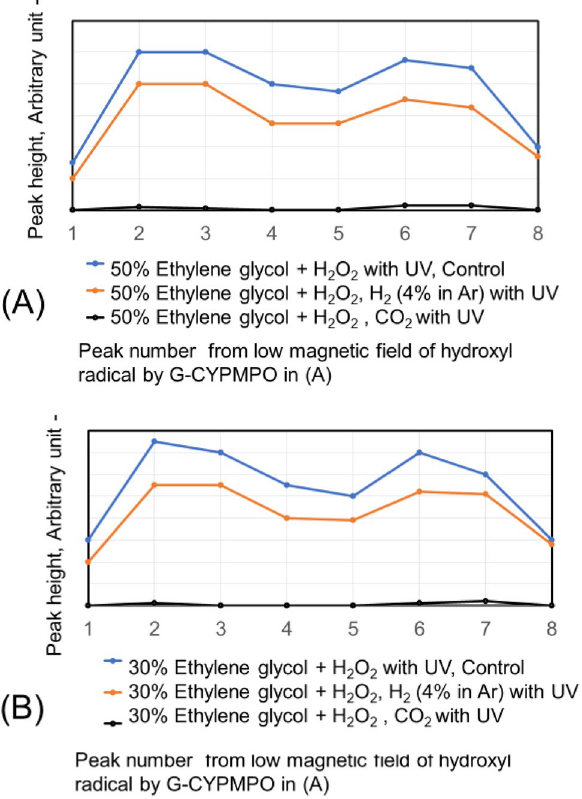
Figure 5. Peaks of hydroxyl radical with ESR by blowing CO 2 and H 2 (4% in Ar) gas nanobubble into 30 and 50% ethylene glycol with 0.1% H 2 O 2 aqueous